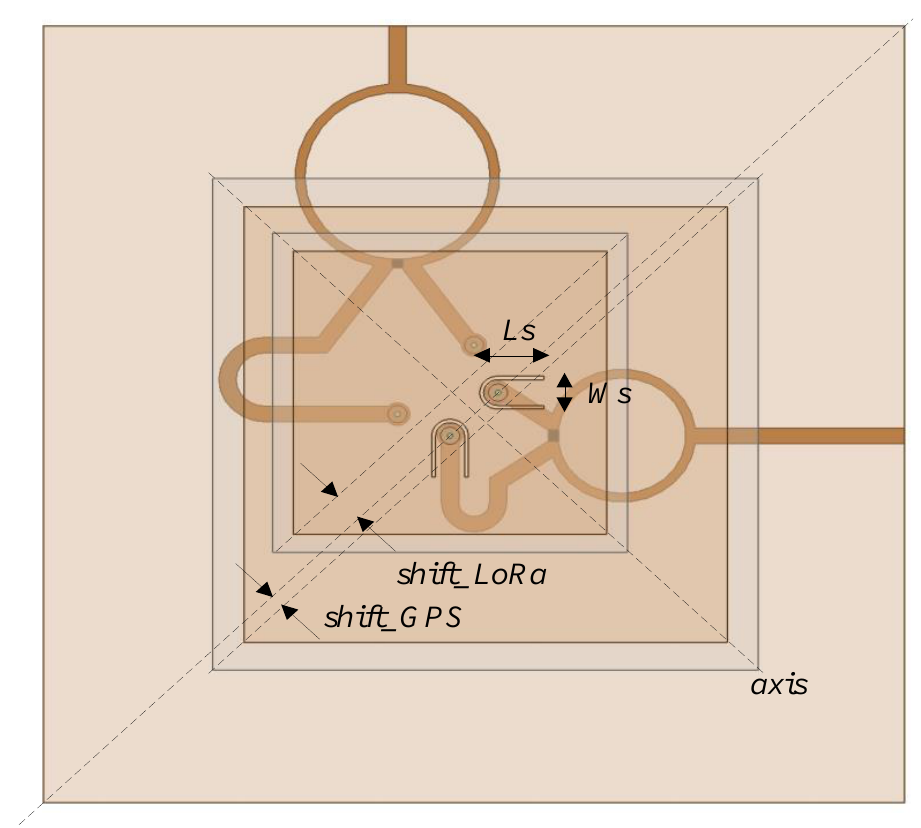
Figure 4. Modification of the placement of patches. Table 1. Main dimensions (mm) of the designed antennas.